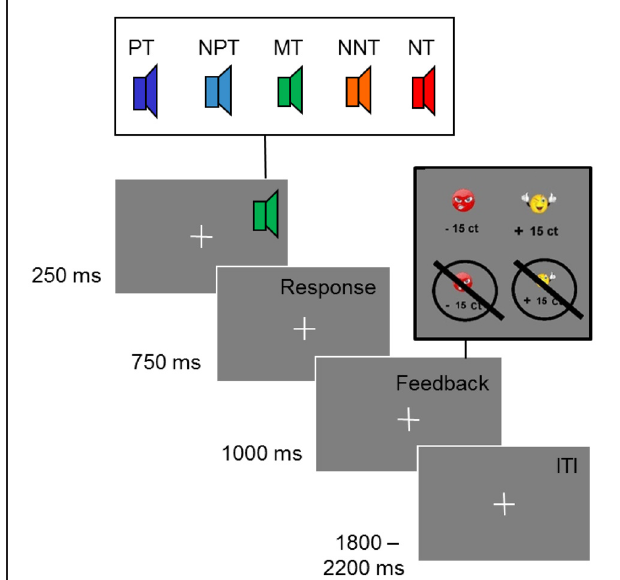
FIGURE 1 | Ambiguous cue-conditioning paradigm. PT, positive tone; NPT, near-positive tone; MT, middle tone; NNT, near-negative tone; NT, negative tone. Participants were instructed to press a button after each tone to obtain reward or avoid loss of reward (0.15 €). After the button press participants received a feedback. In case of a correct identification of the positive tone, they saw a smiley indicating a monetary gain. For a wrong button press or no response, they saw a crossed smiley indicating that they had missed the chance to earn money. A correct identification of the negative tone was followed by a picture of a crossed frowney indicating that they had successfully avoided loosing money; for a wrong button press, participants lost money and saw a frowney. No feedback was presented after intermediate tones (NPT, MT, NNT) and after 4% of the reference tones (PT, NT). The inter-trial-interval (ITI) was jittered between 1800 and